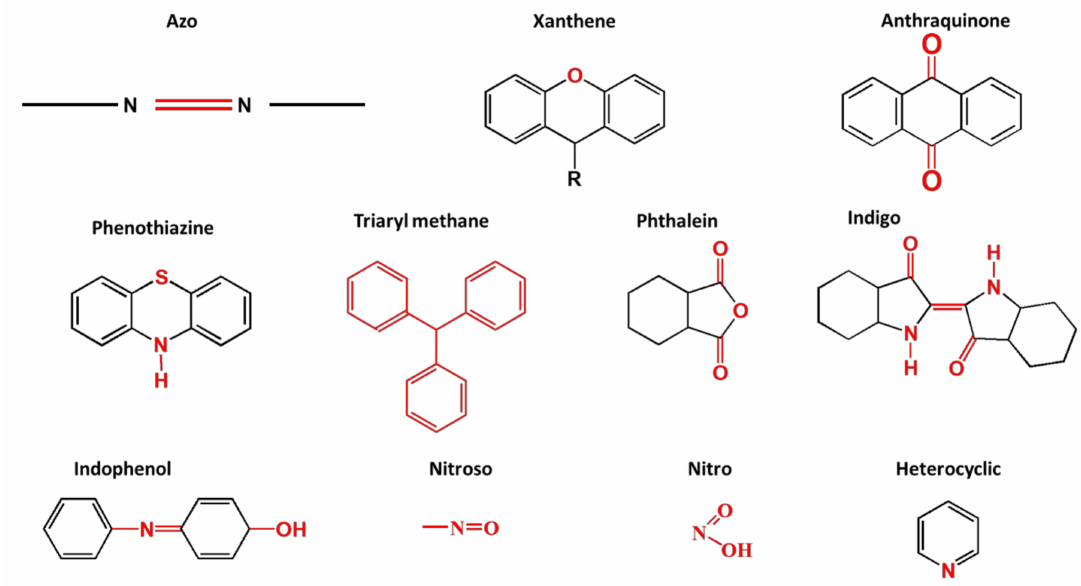
Figure 3. Chromophotic structures of the main synthetic groups in organic